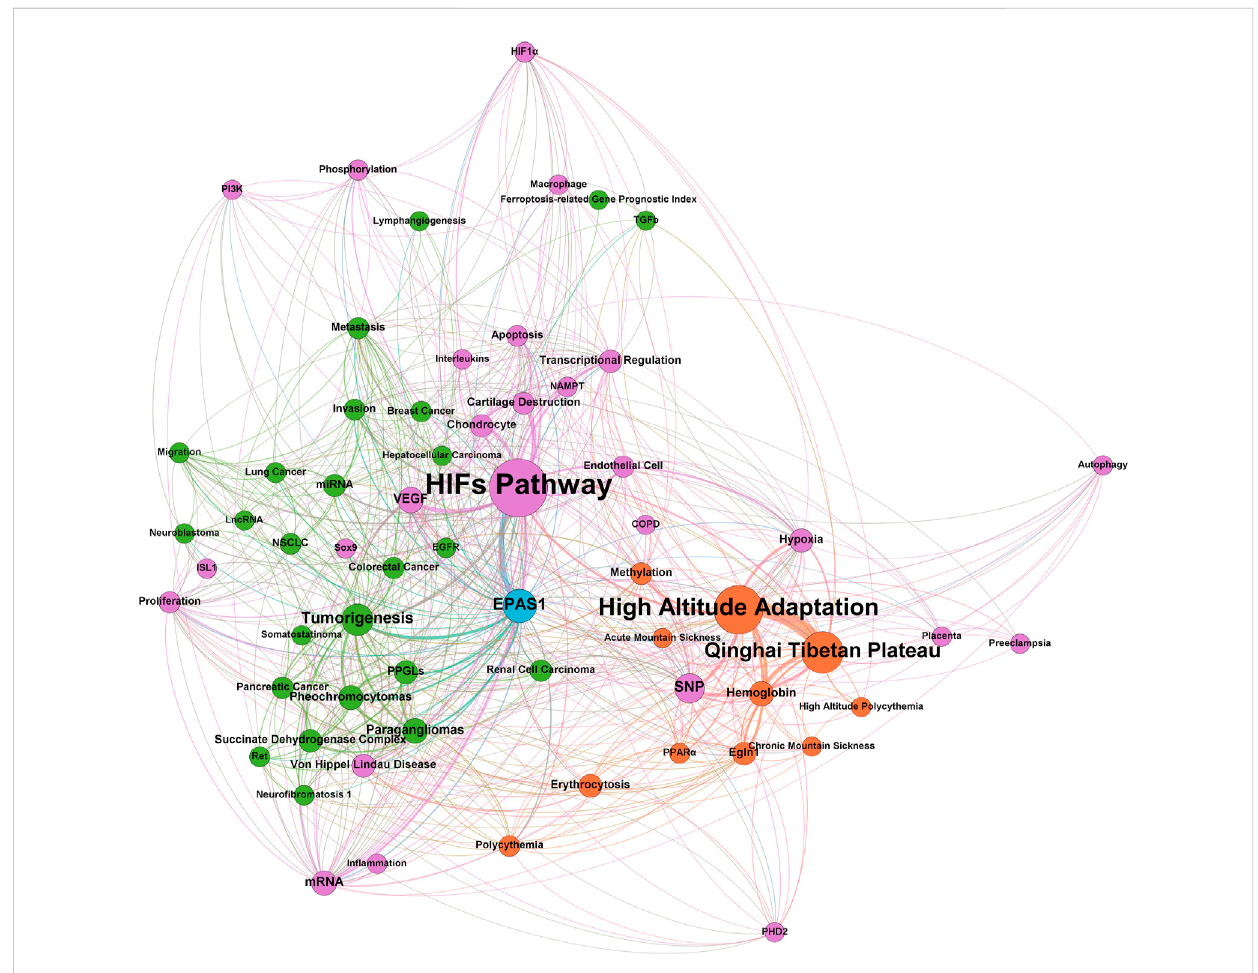
FIGURE 1 Bibliometrics analysis of EPAS1 in the past 20